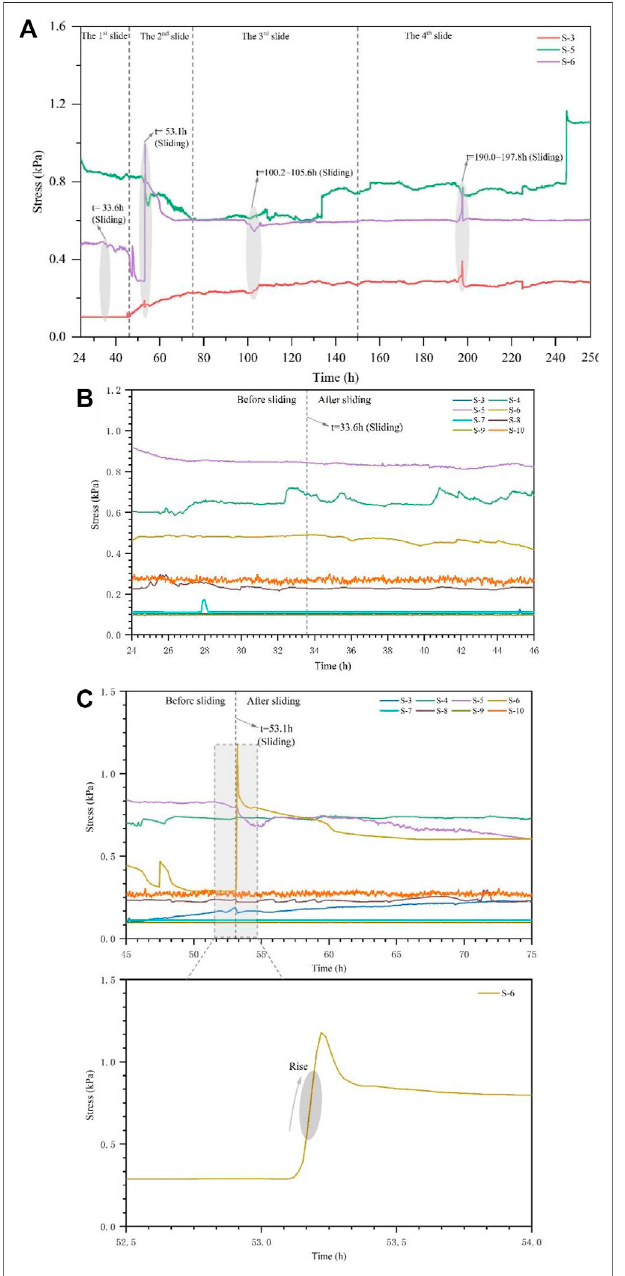
FIGURE 12 | Variation of soil stress during slope failure. (A) Soil stress during the whole sliding, (B) soil stress during 1st slide, (C) soil stress during the 2nd slide, (D) soil stress during the 3rd slide, and (E) soil stress during the 4th slide.